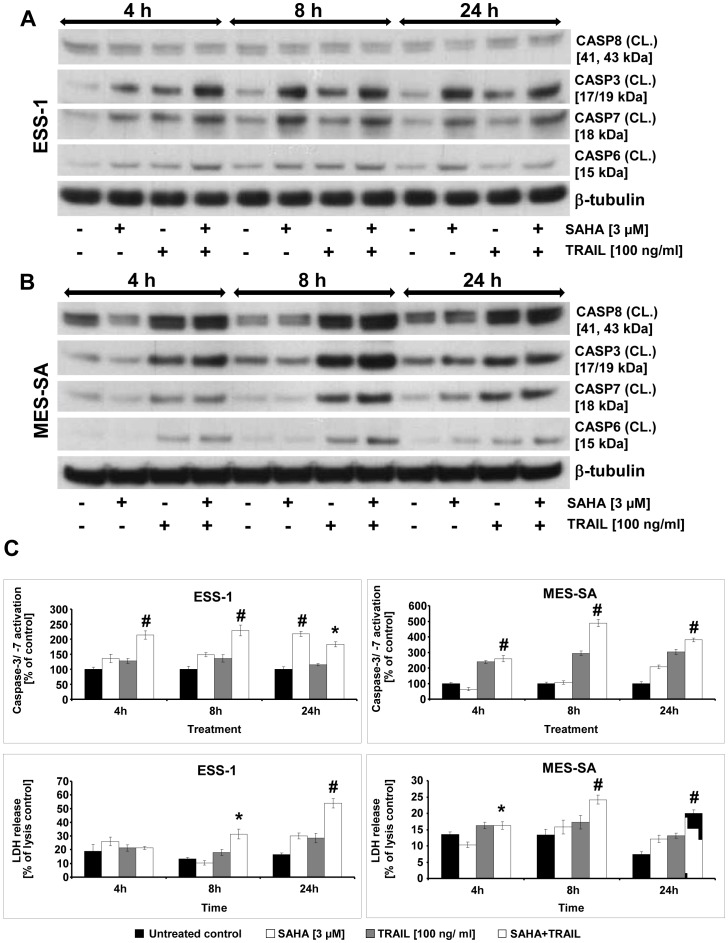
Time course of combined SAHA and TRAIL-induced caspase activation in uterine sarcoma cells.Western blot analysis of ESS-1 cells (A) and MES-SA cells (B) after treatment with 3 μM SAHA and/or 100 ng/ml TRAIL for 4, 8, and 24 hours to compare the induction of apoptosis. Untreated cells were used as control. Cell extracts were prepared, then 50 μg of protein were loaded onto a SDS-PAGE (12% Bis-tris gel) of each sample, and blotted onto nitrocellulose membrane. Subsequently, the membrane was incubated with the indicated antibodies against cleaved (CL.) caspases-3, -6, -7, -8, and β-tubulin (as loading control) followed by detection with a secondary hrp-coupled antibody. The molecular weights of presented bands are indicated in brackets. Note the weak expression of caspase-8 in ESS-1 cells (C) The amount of caspase-3 and -7 activation (Caspase-Glo 3/7 Assay; upper panel) and LDH release (CytoTox-ONE Homogeneous Membrane Integrity Assay; lower panel) of both uterine sarcoma cell lines was measured 4, 8, and 24 hours after treatment with 3 μM SAHA and/or 100 ng/ml TRAIL. The results are expressed as percentage of relative caspase-3/-7 activation or LDH release as compared to the untreated control or lysis control, respectively. Cells were seeded at a density of 5×103 cells per well. Each value represents the average of 3 independent experiments with 5 replicates each. Asterisks (* p<0.05) or number signs (# p<0.001) indicate statistically significant differences between the combined SAHA/TRAIL treatment and the control.